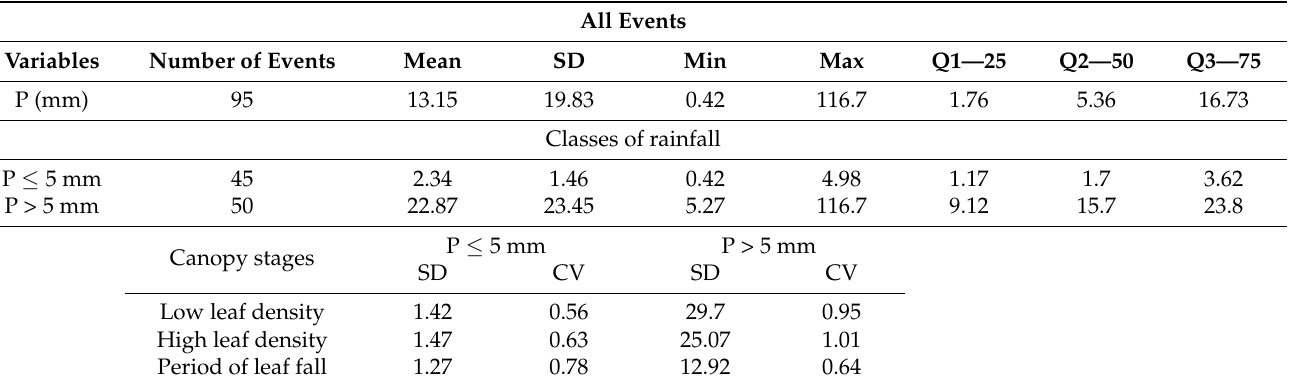
Table 3. Descriptive statistics of the monitored rainfall events.